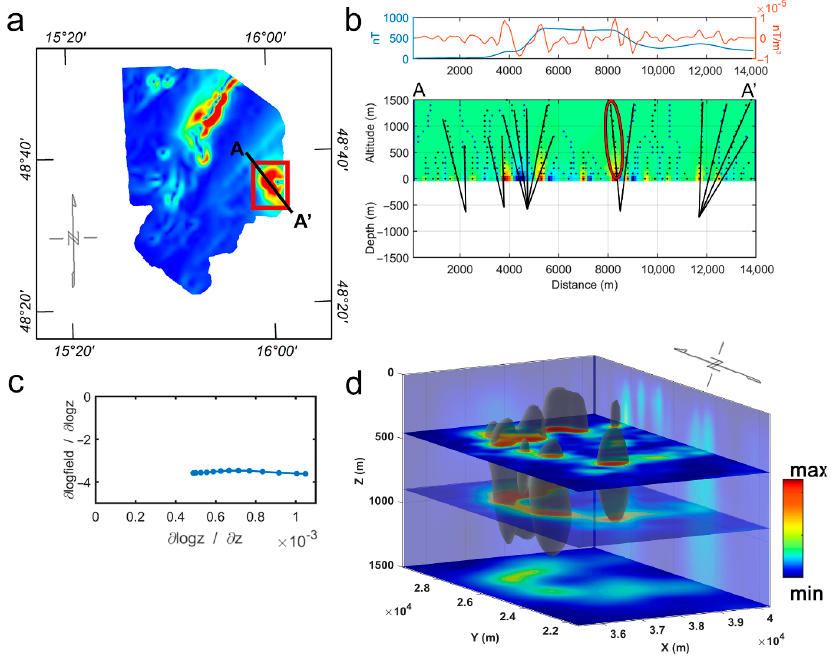
Figure 9. Structural index and depth estimation for magnetic data: ( a ) EHD map showing the circular pattern chosen for our analysis (red rectangle); ( b ) ridges relative to the 3rd derivative of the magnetic field computed along the profile AA’; ( c ) evaluation of the SI N by the scaling function analysis; ( d ) 3D imaging of the sources in the analysis area performed on total gradient of magnetic data; the depth to the sources is shown by the maxima of the DEXP signal (normalized dimensionless units are used). An average acquisition height of 100 m should be subtracted from the outcomes of the Multiridge Geometric Method and DEXP.